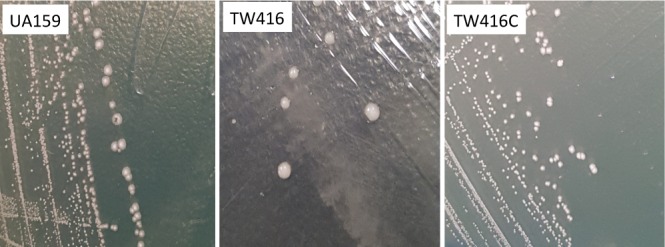
Colony morphology of the mecA mutant. S. mutans wild-type (UA159), the mecA mutant (TW416) and its complement strain (TW416C) were grown on BHI agar plates. Relative to the rough, dry colonies of UA159, the colonies of TW416 were round, mucoid, and smooth. Images were taken using Samsung Galaxy Note V.